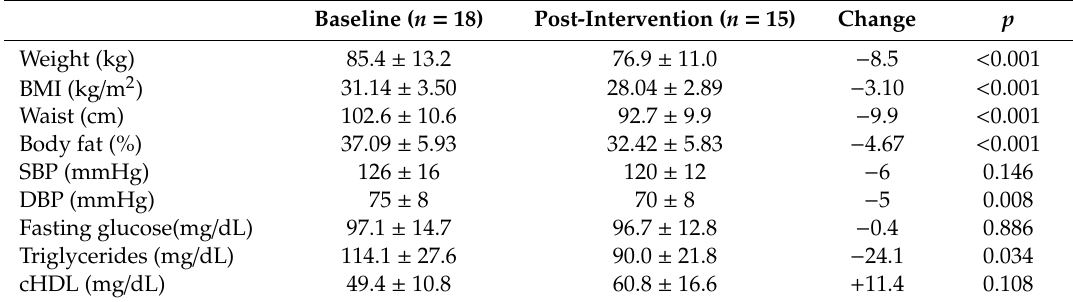
Table 2. Change in clinical characteristics at baseline and after 12 weeks of intervention.